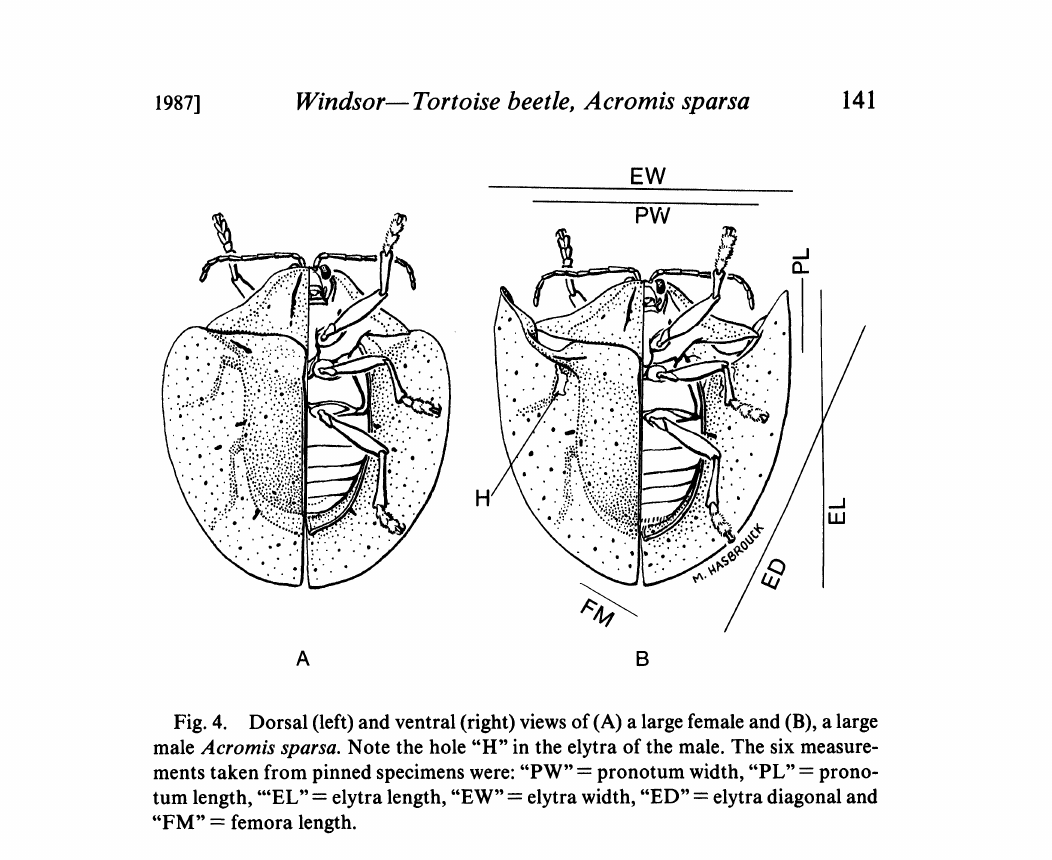
Fig. 4. Dorsal (left) and ventral (right) views of (A) a large female and (B), a large male Acromis sparsa. Note the hole "H" in the elytra of the male. The six measure- ments taken from pinned specimens were: "PW" pronotum width, "PL" prono- tum length, ’"EL" elytra length, "EW" elytra width, "ED" elytra diagonal and "FM" femora